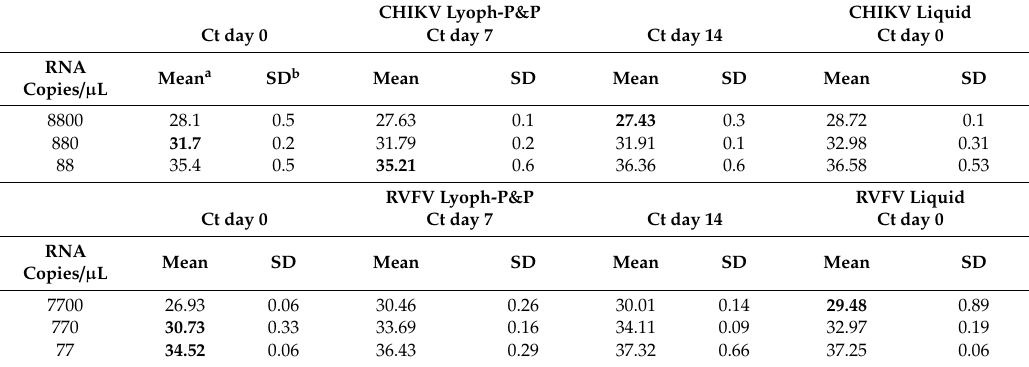
Table 5. Stability at 4 ◦ C after rehydration of Lyoph-P&P compared with liquid format. CHIKV Lyoph-P&P